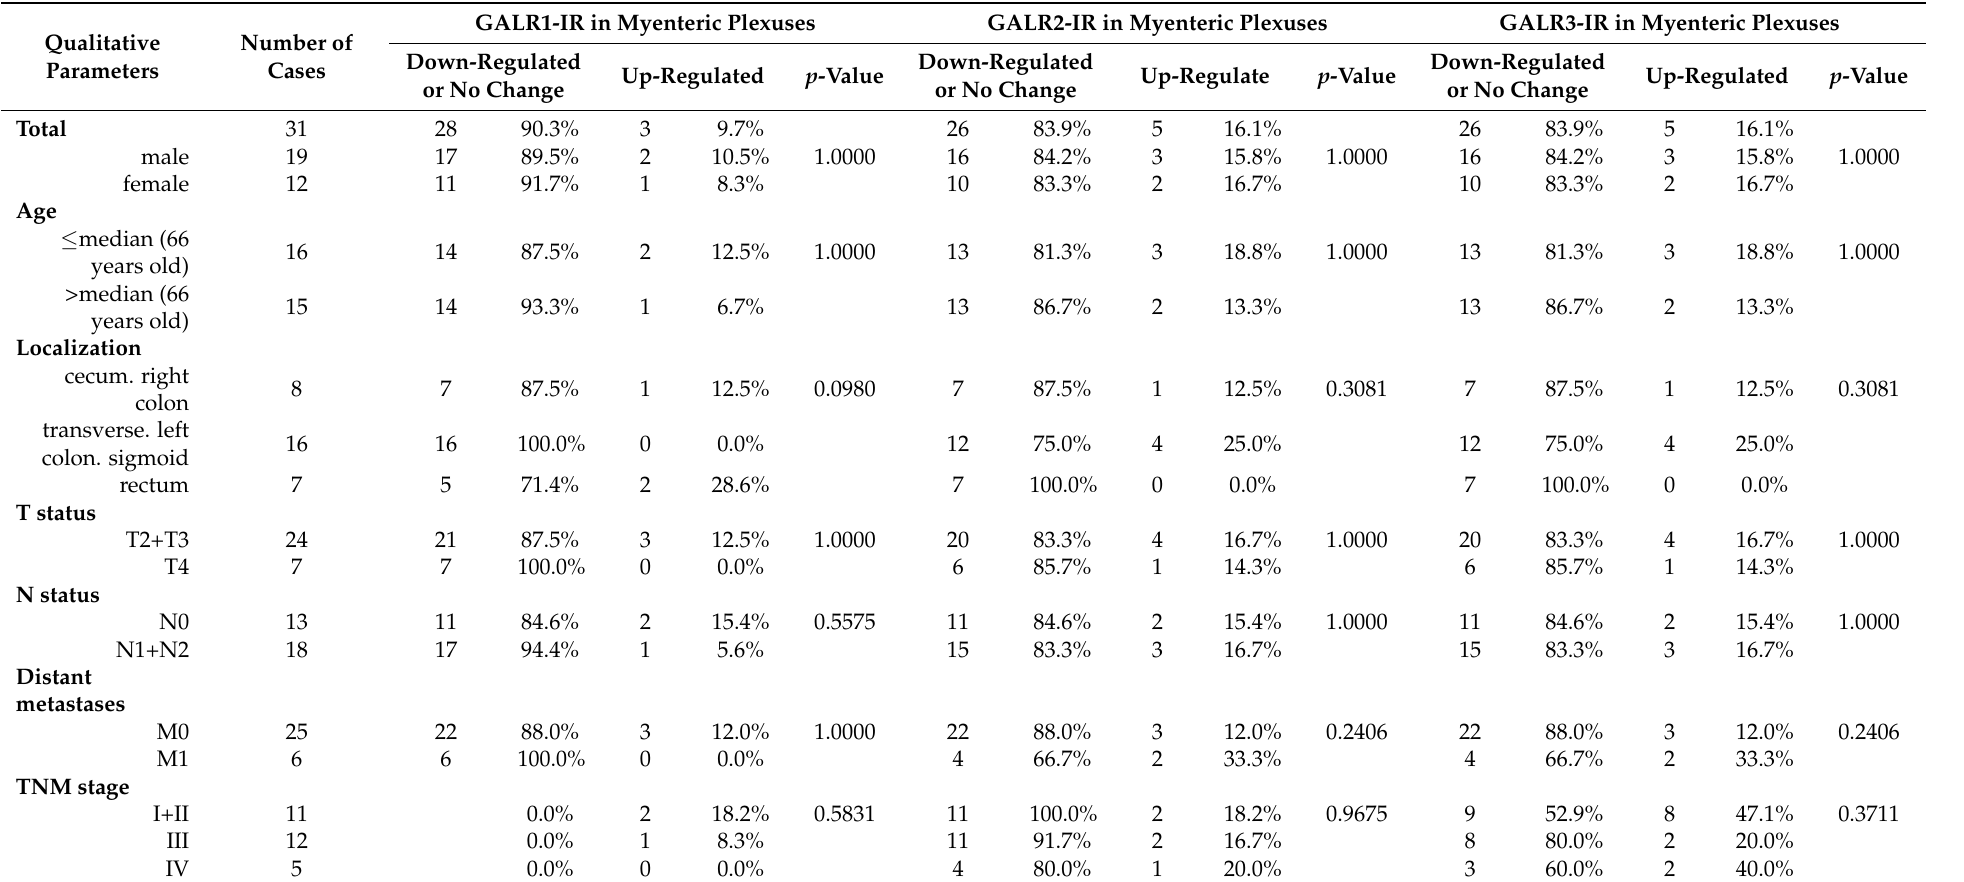
Table 2. Associations between demographic and clinico-pathological features of colorectal cancer patients (n = 31) and relative expression levels of galanin receptors in myenteric plexuses determined by